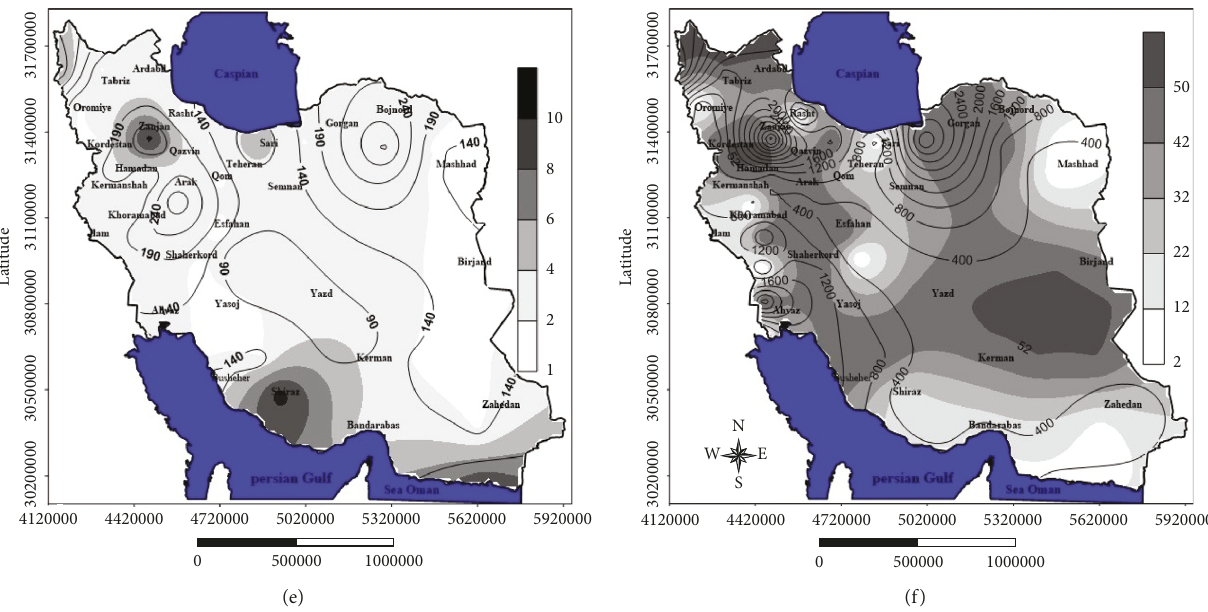
Figure 4: Spatial distribution of variance (contour) and cycles (shaded) of Iran’s thunderstorms during various periods. (a) 1961–1970, (b)